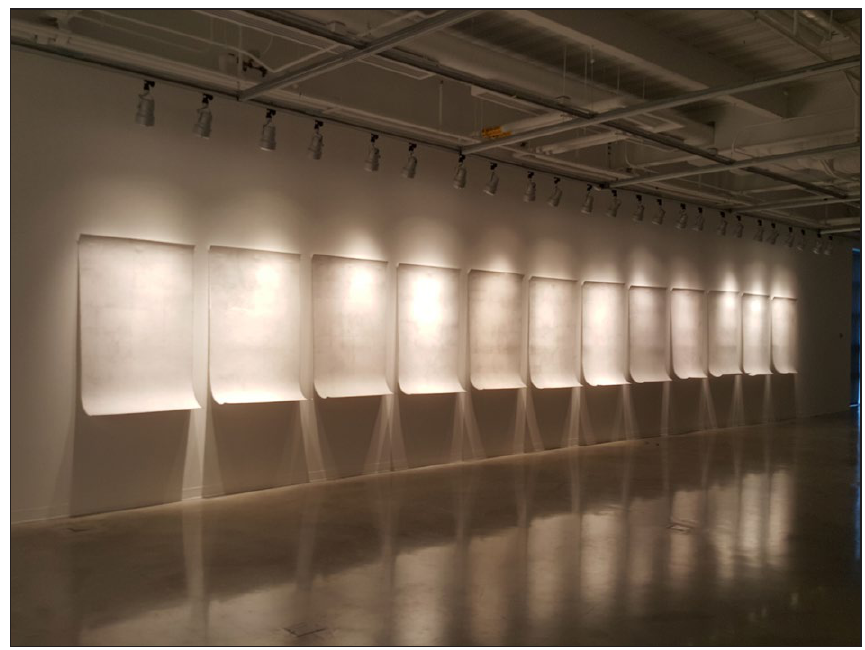
Figure 18: Sarah Irvin, Carpet Transfer Series, Carbon transfer on paper, 60 × 594 inches,